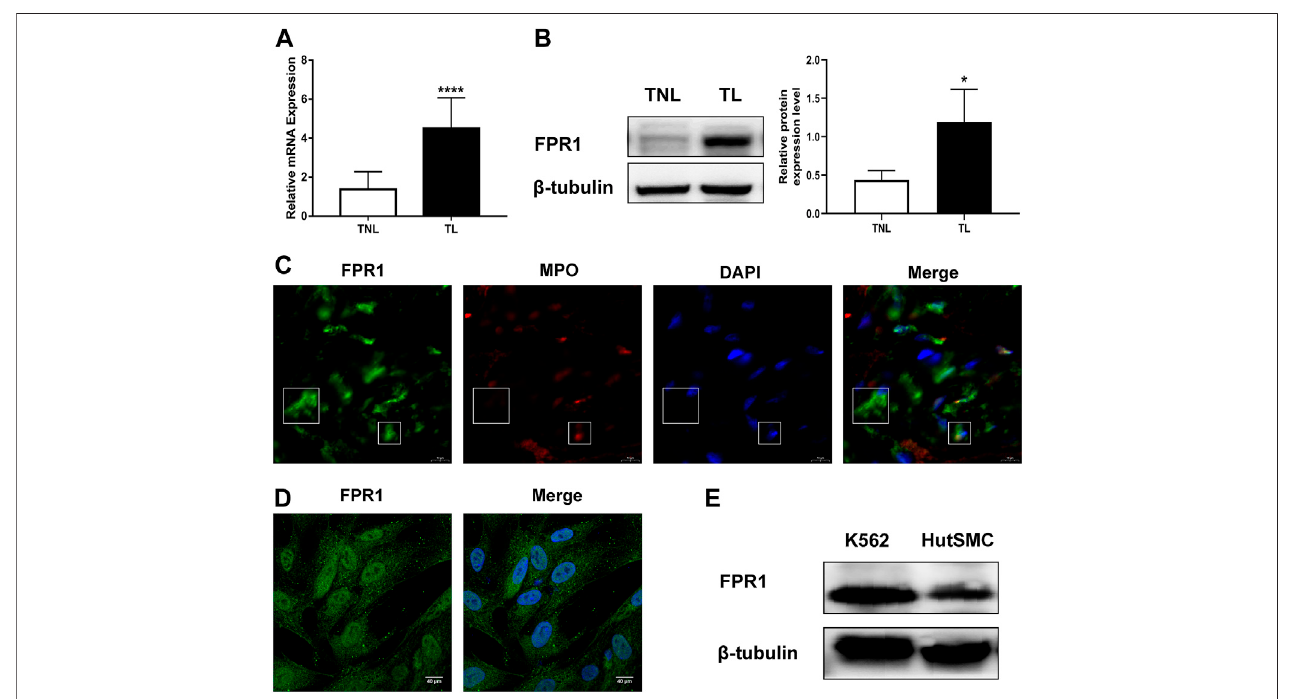
FIGURE4| FPR1expressioninhumanlaboringmyometrium. (A,B) RT-qPCRandwesternblottingoftheexpressionlevelofFPR1inTLmyometriumcomparedto TNL myometrium. * p < 0.05, **** p < 0.0001. (C) Frozen sections of TL myometrial tissues were stained by immuno fl uorescence for the expression of FPR1 (Alex Fluor ® 488, green) and MPO (Cy3, red), as described in Materials and Methods. Cell nuclei were stained with DAPI (blue). Images shown are representative of three independent experiments with similar results. Scale bar, 10 µm. (D) Immuno fl uorescence for the expression of FPR1 (green), co-labeled with DAPI (blue) in HutSMCs (human uterine smooth muscle cells). Scale bar, 40 µm. (E) The expression of FPR1 in HutSMCs with K-562 cell line as positive control by WB assay.